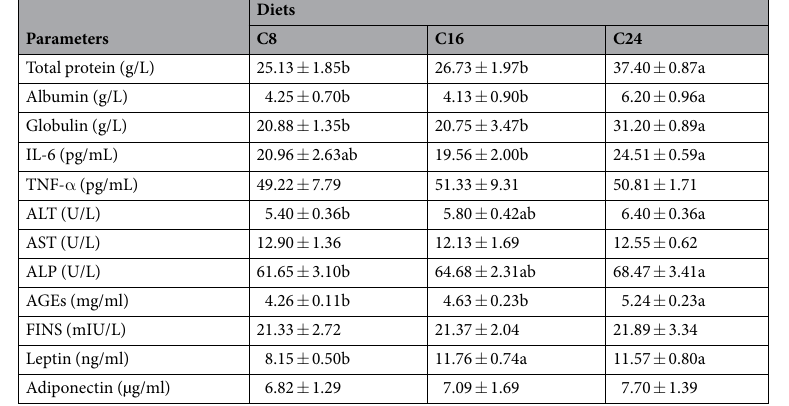
Table 1. Serum parameters of Japanese flounder after the 10-week feeding trial. Values are presented as mean ± S.D., n = 3 (8 fish/replicate). Values followed by different letters in the same row are significantly different ( P < 0.05).